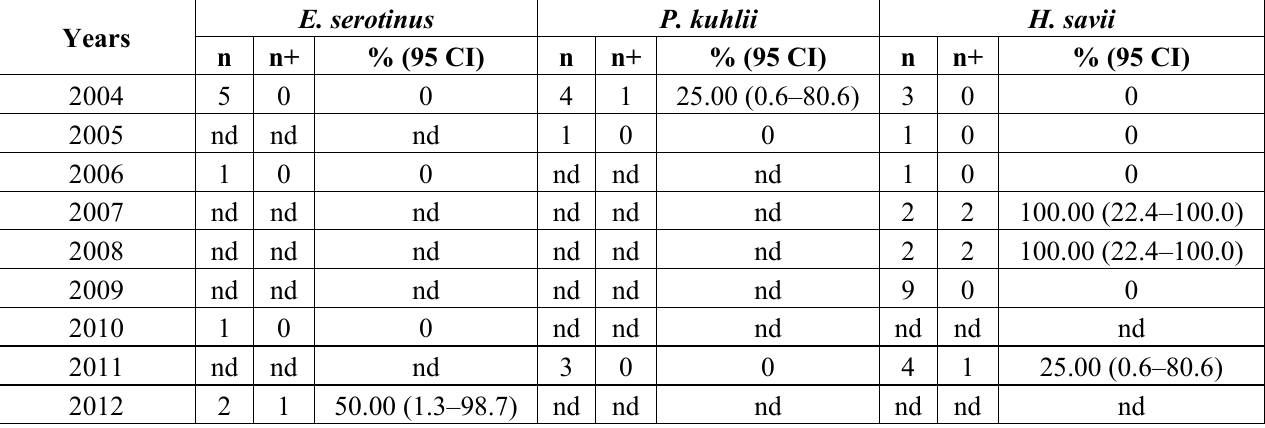
Table 4. The number of bat samples analyzed, by bat species and year.